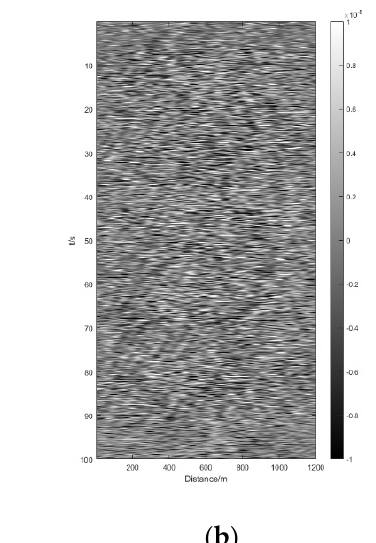
Figure 2. Random passive ‐ source waveform.